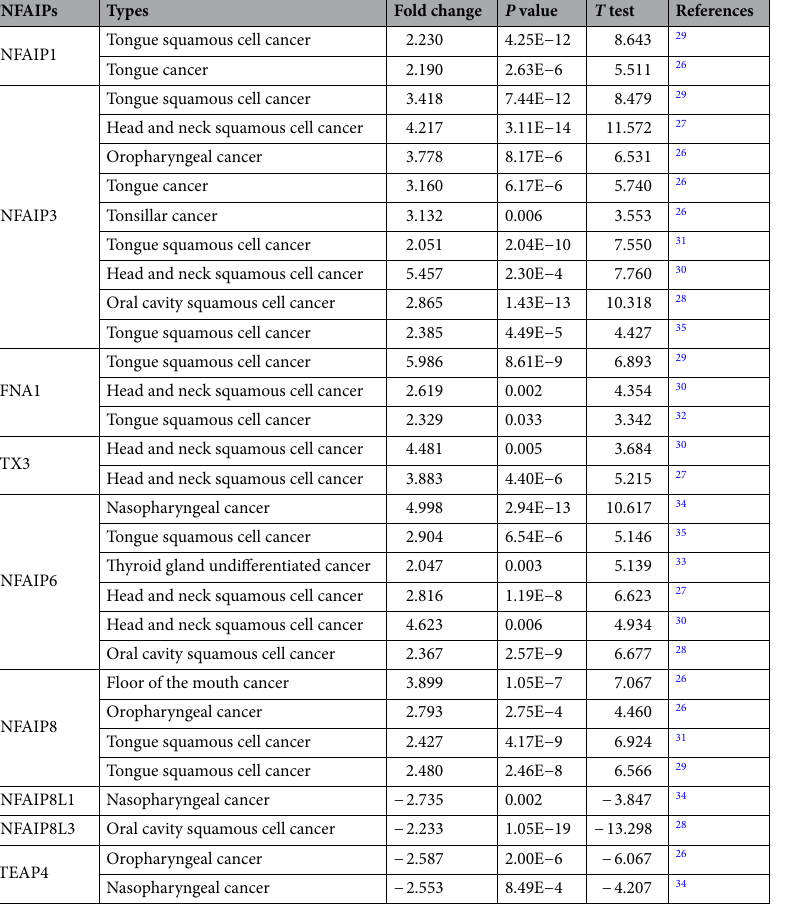
Table 1. The mRNA levels of TNFAIPs in different types of HNC tissues and normal tissues